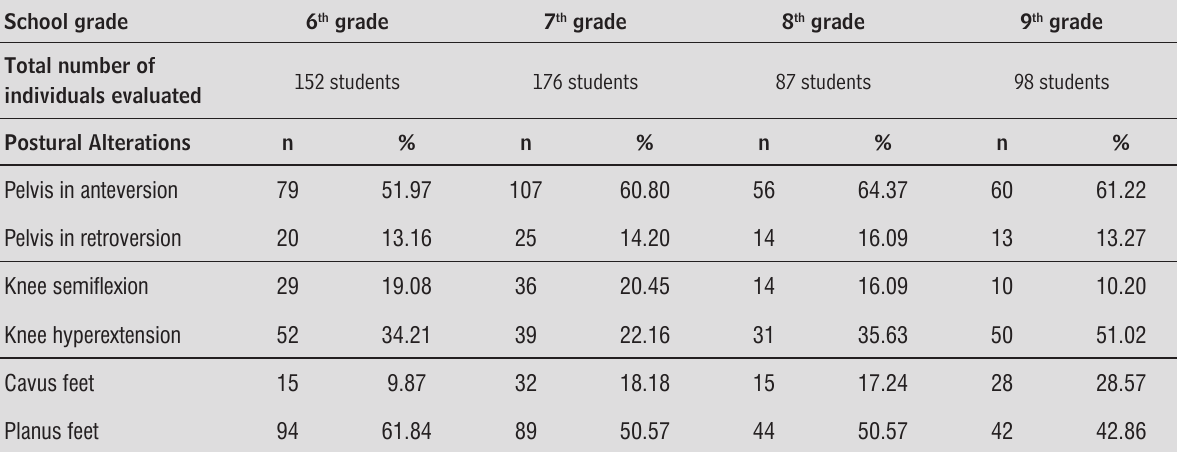
Table 4 - Frequency of postural alterations per school